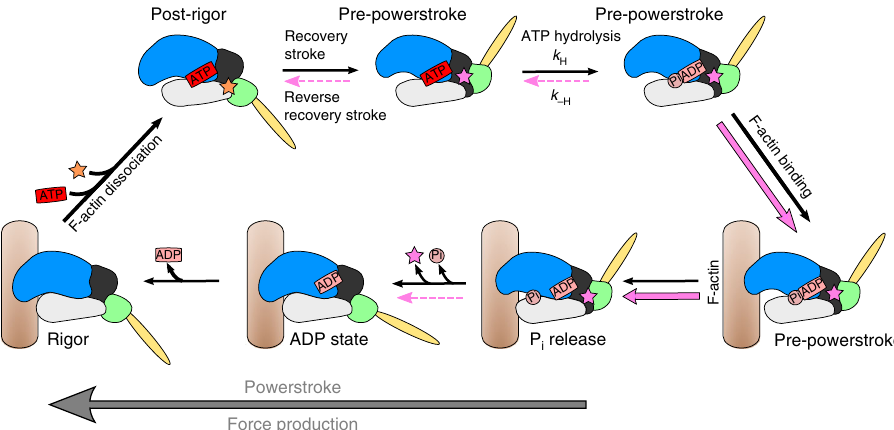
Fig. 5 Effect of OM on the chemomechanical actomyosin ATPase cycle. The motor cycle is presented, highlighting the conformational changes that the motor domain undergoes along the motor cycle as well as the states to which OM can bind in either the “ PR ” site ( orange star 12 ) or the “ PPS ” site ( pink star ). ATP hydrolysis stabilizes the Pre-powerstroke state, as does the binding of OM to the “ PPS ” site, which greatly slows the reversal of the recovery stroke ( dotted pink lines ). Rebinding to F-actin (brown fi lament) in this PPS state triggers a series of conformational changes associated with force production (Powerstroke). OM increases the number of heads ready to produce force ( red square ). OM binding in the “ PPS ” site increases the rate of the transition that allows the release of P i ( pink arrows ) since this step occurs while the lever arm stays primed. The following transition destabilizes the “ PPS ” -binding pocket since it requires the swing of the lever arm. Time-resolved FRET studies 18 have shown that this step is slowed ( dotted pink arrow ). OM thus increases force production by increasing the number of myosin heads bound to F-actin in the early stages of force